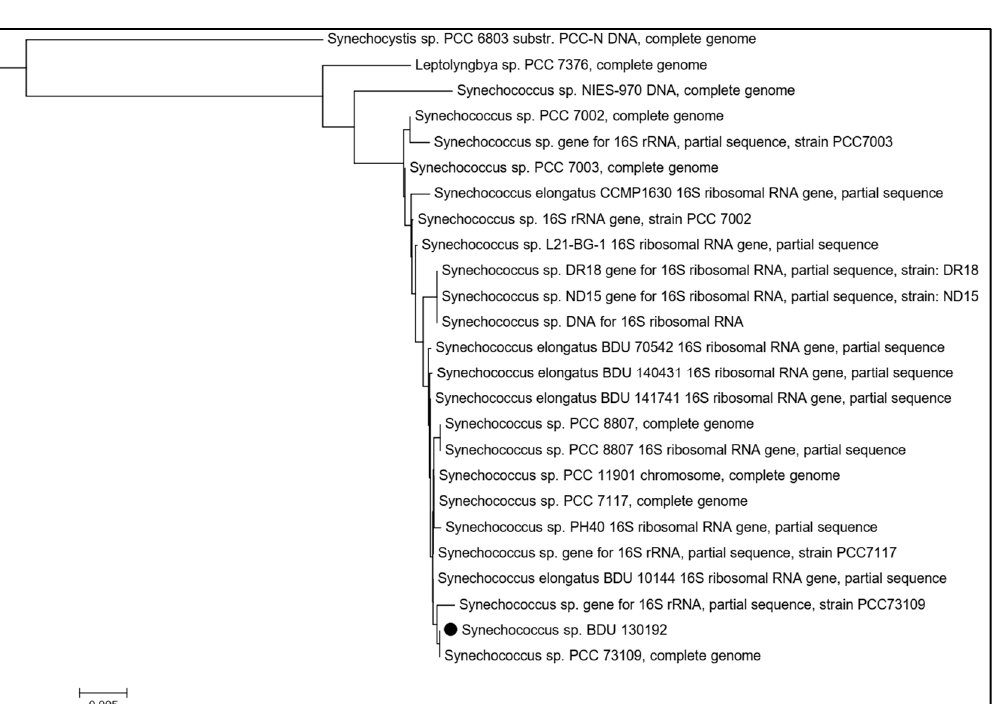
Table 1. Biomass compositions of Synechococcus sp. BDU 130192 and Synechococcus sp. PCC 7002. S. No.